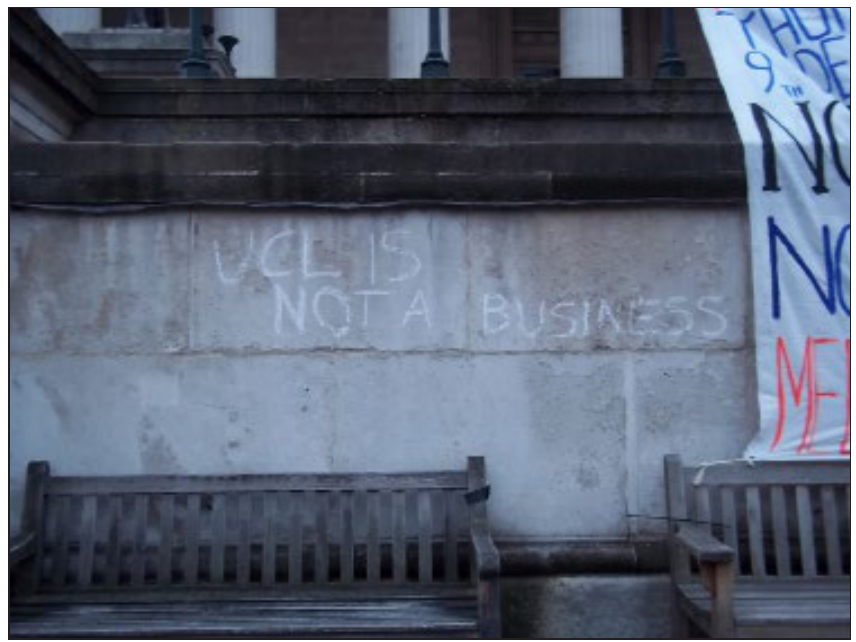
Figure 4: Chalk graffiti on UCL walls during the students’ protests of 2010 (Photo: Renata F.